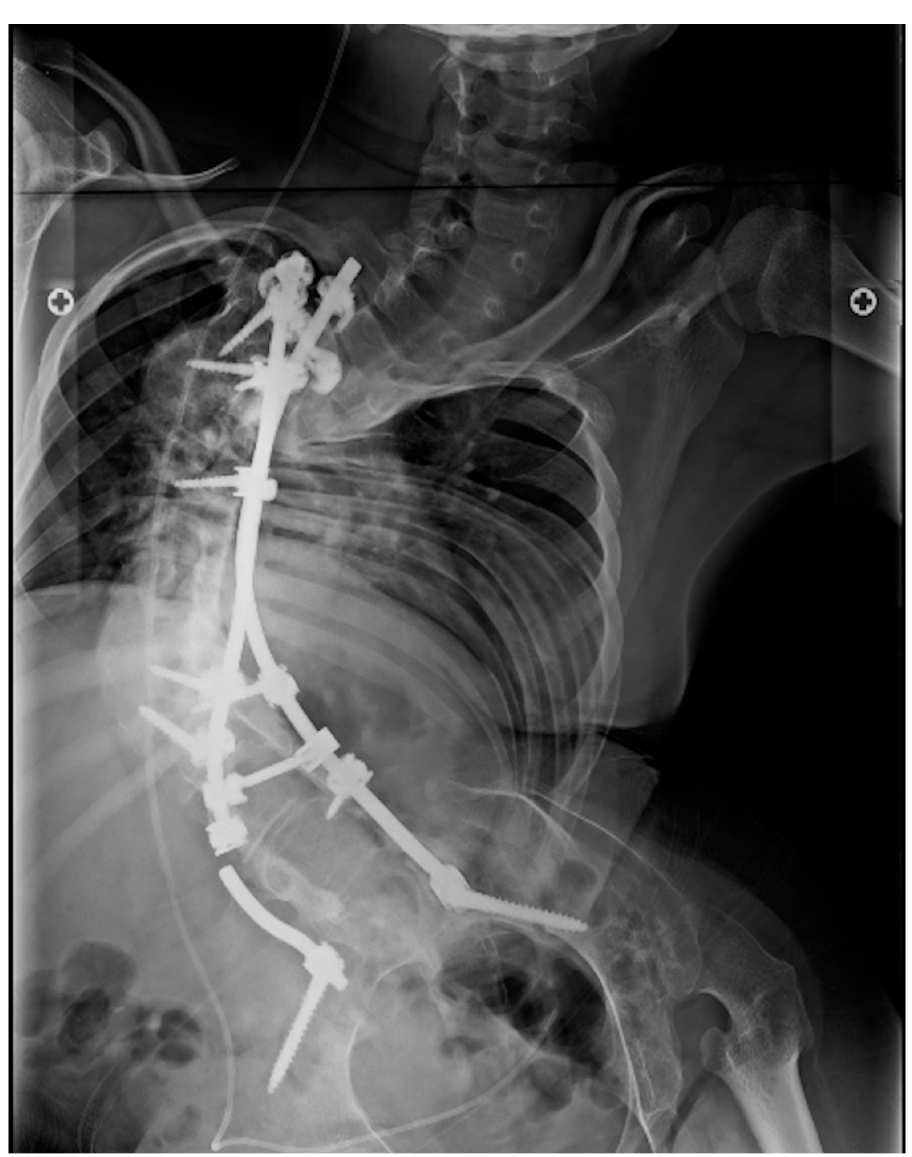
Figure 2. Anteroposterior X-ray showing rod breakage on the right.